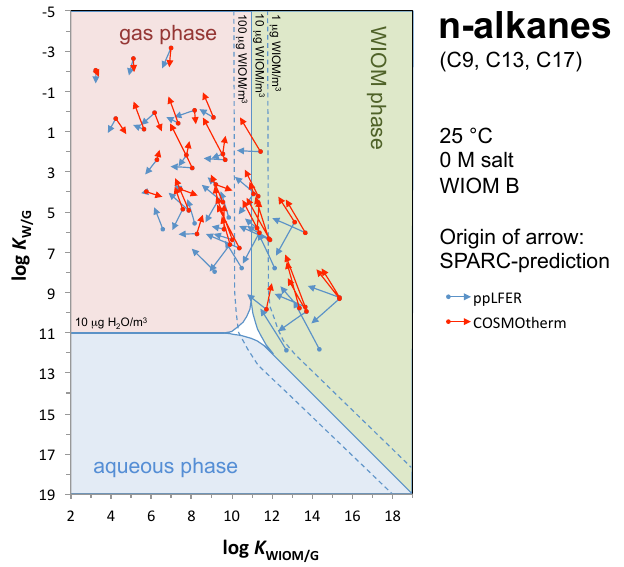
Figure 5. Arrows indicating the uncertainty of chemical placement in the partitioning space based on the discrepancy of K WIOM / G and K W / G predictions made with SPARC (origin of arrows), ppLFERs (tip of blue arrows) and COSMOtherm (tip of red arrows). For some compounds, no COSMOtherm predictions are